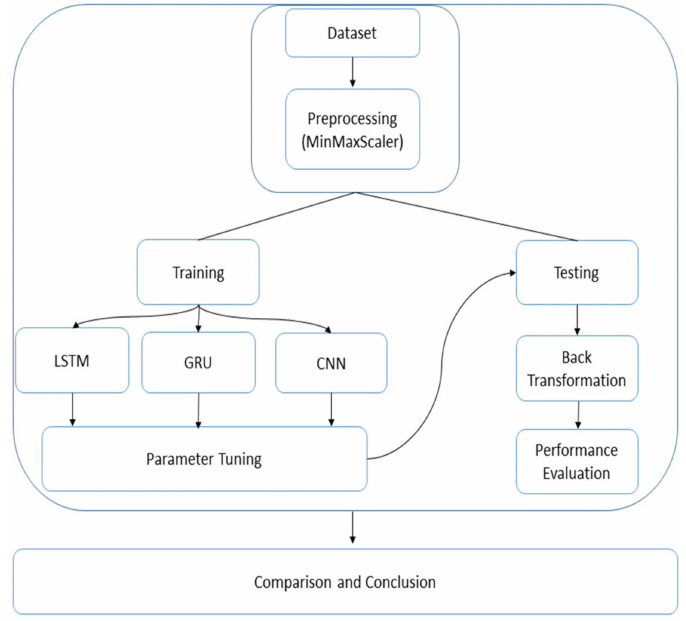
Figure 4. Summary of the forecasting